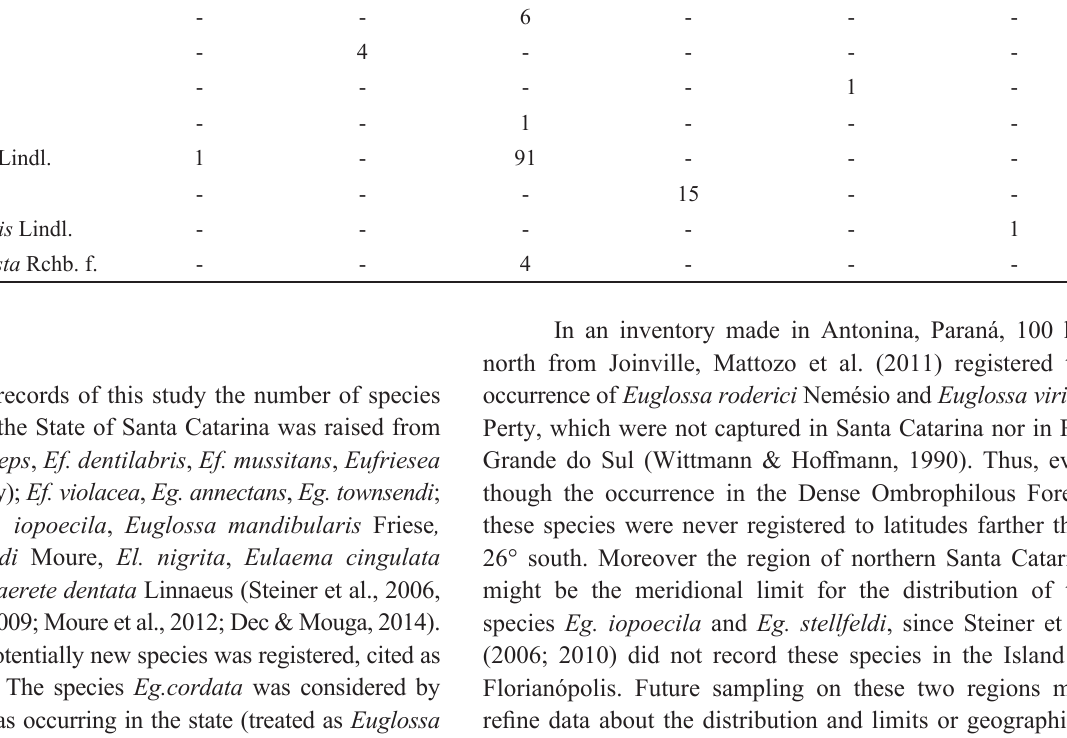
Table 4 . Number of orchid pollinaria recorded on Euglossini males captured in the six locations studied in the northern regions of Santa Catarina. Orchid species